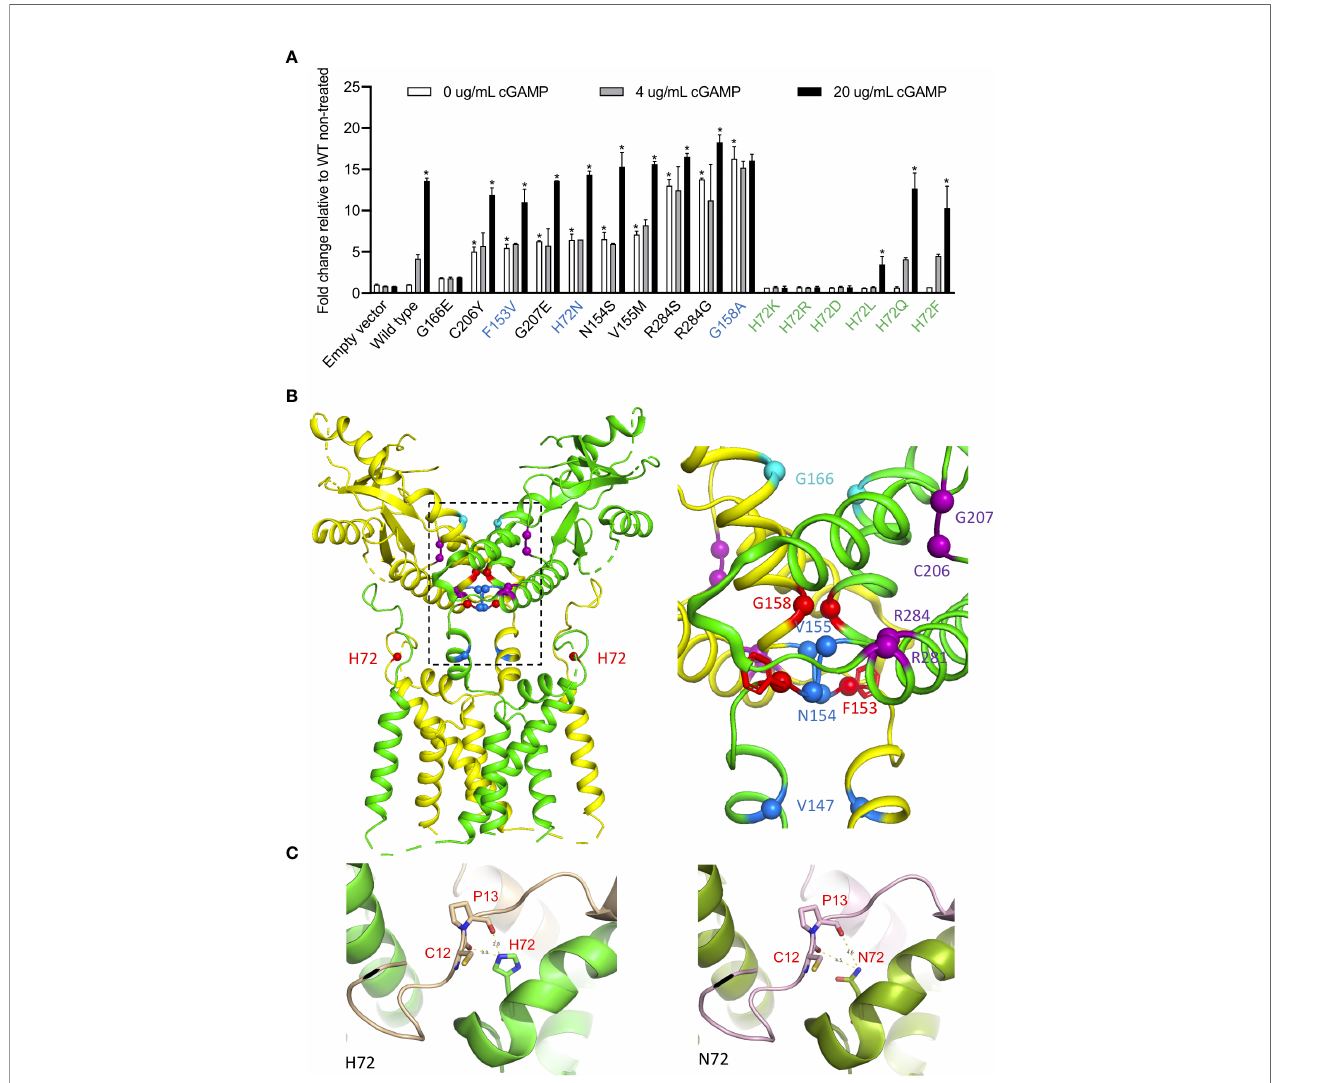
FIGURE 2 | H72N, G158A, F153V variants lead to autoactivation. (A) Novel STING variants lead to strong STING autoactivation as measured by IFNB1 reporter activation in 293T cells. 50 pg of various STING constructs were transfected. The three novel SAVI-causing variants are labeled in blue, and other H72 variants are labeled in green. The SAVI-causing variants are shown in the order of autoactivating potential. *An asterisk above the white bar designating 0 m g/ml cGAMP indicates signi fi cant change compared (p<0.0001) to wildtype (WT) non-treated, by ordinary one-way ANOVA Dunnett ’ s multiple comparisons tests. An asterisk above the black bar designating 20 m g/ml cGAMP indicates signi fi cant change (p<0.003) of 20 m g/ml cGAMP treated cells compared to the respective non-treated cells; by two-way ANOVA, Bonferroni ’ s multiple comparisons test. Data are presented as mean±SD of duplicates. Similar results were obtained in independent experiments. (B) Ribbon structural model of apo STING dimer, with the two subunits colored in yellow and green. Location of SAVI-causing variants are highlighted with spheres, with the three novel variants in red, variants in the connector helix loop region in blue, p.G166E variants in the ligand-binding pocket in cyan, and variants in the polymer interface in purple. The major mutation region is enlarged on the right, showing how the F153 phenyl ring buttress the polymer interface. (C) Structure model of H72 compared to N72 indicates increased dimer fl exibility of p.H72N mutation, which confers gain-of-function. The two STING monomers forming a dimer are in green and gold/purple